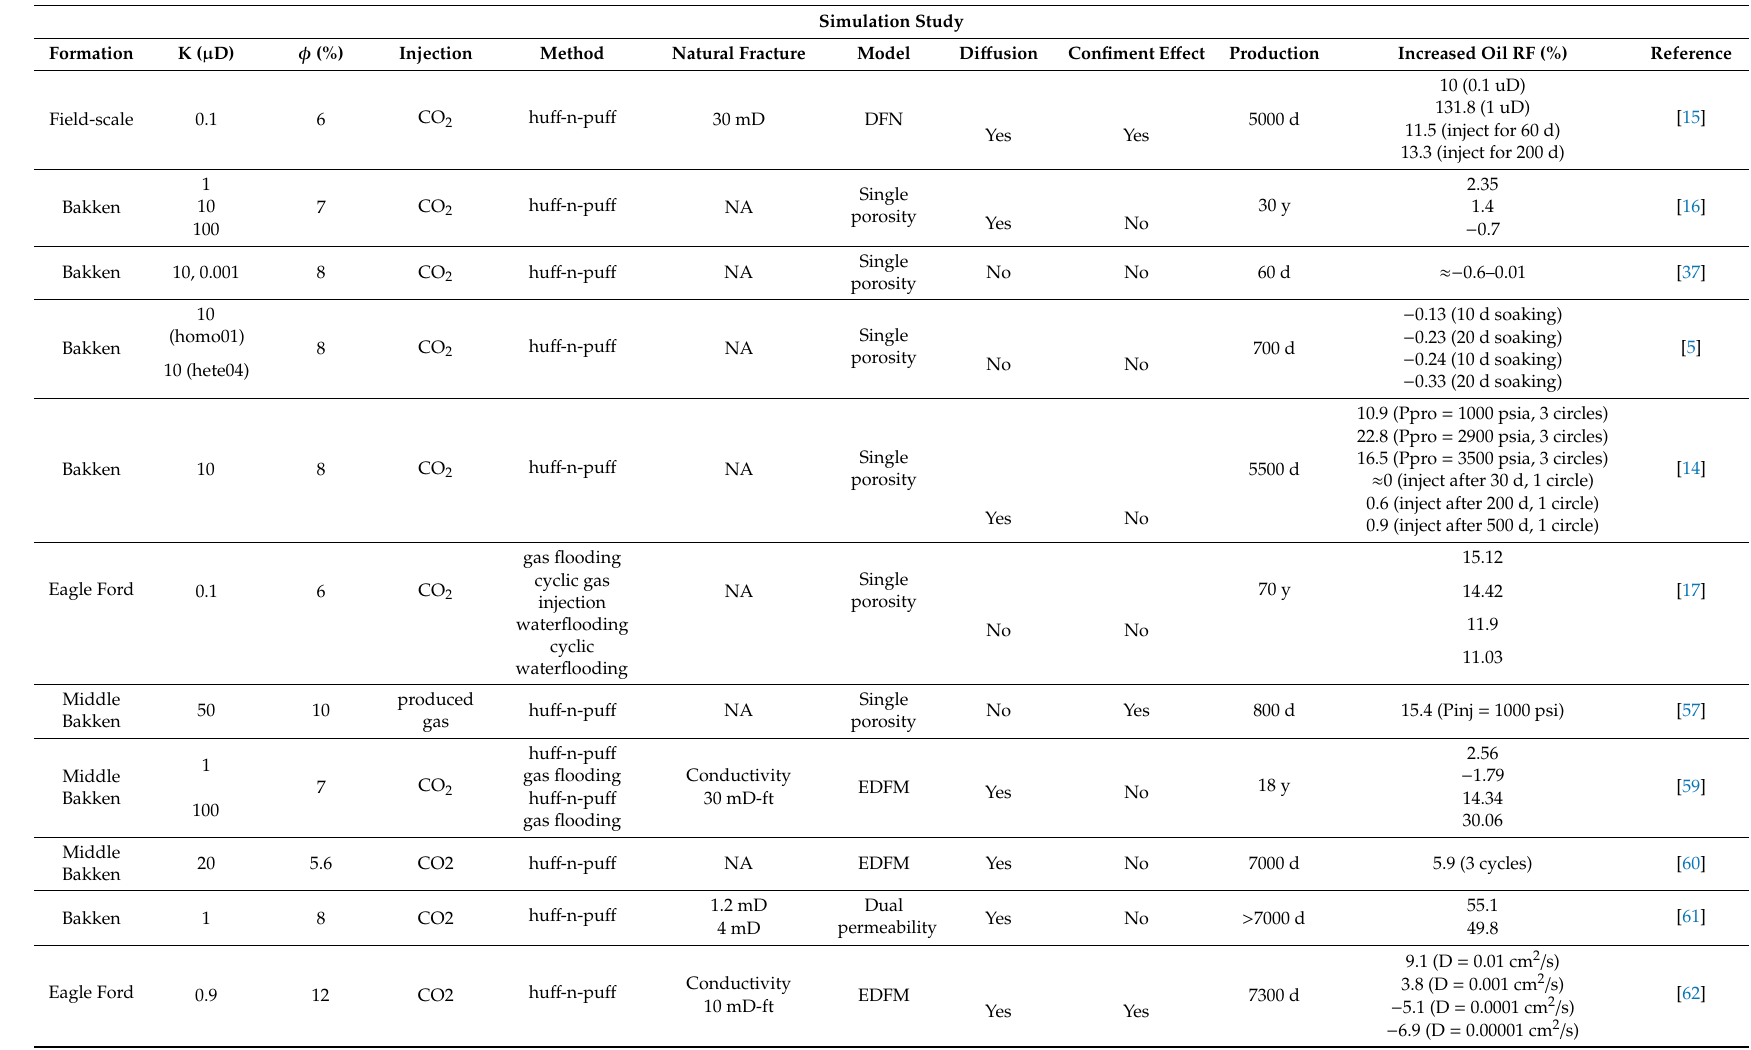
Table 2. The simulation studies about di ff erent gas injection approaches in shale reservoirs for